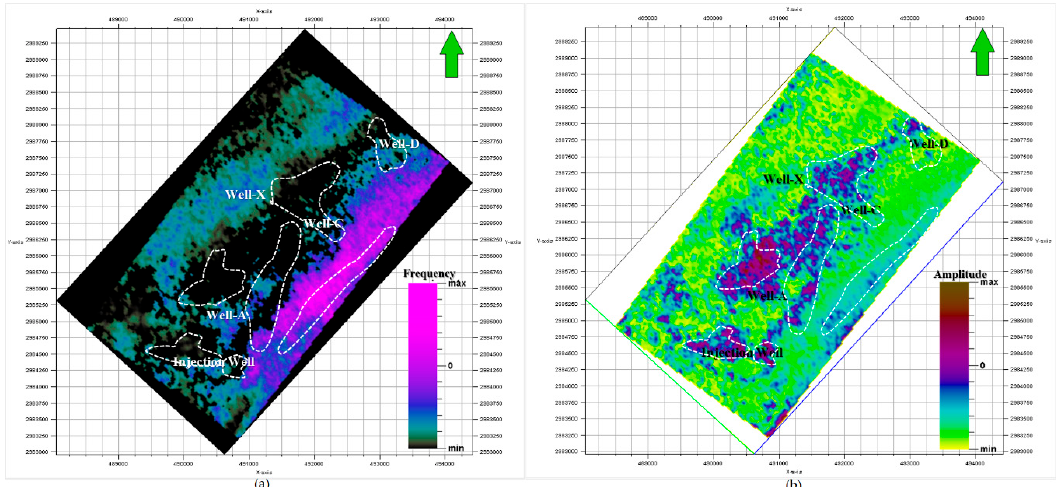
Figure 20. 3D Seismic attributes map, ( a ) low-frequency attenuation gradient, ( b ) amplitude above average at Z = 2200 ms, demonstrating the high amplitude (maroon) is being consistent with low-frequency (black).